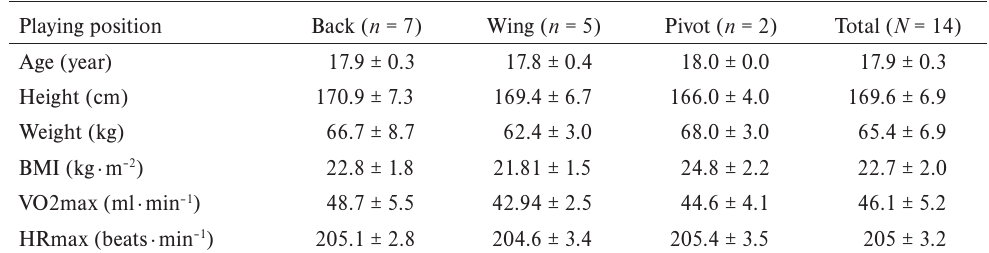
Specification of the participants based on their playing positions. Data are presented as mean ± SD. Playing